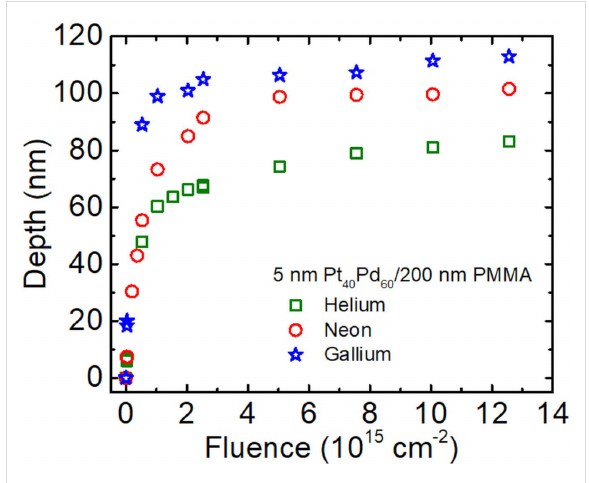
Figure 2: Fluence dependence on the irradiation-induced surface depthening for a 5 nm Pt 60 Pd 40 /200 nm PMMA sample, irradiated with 25 keV He + , Ne + , and Ga +